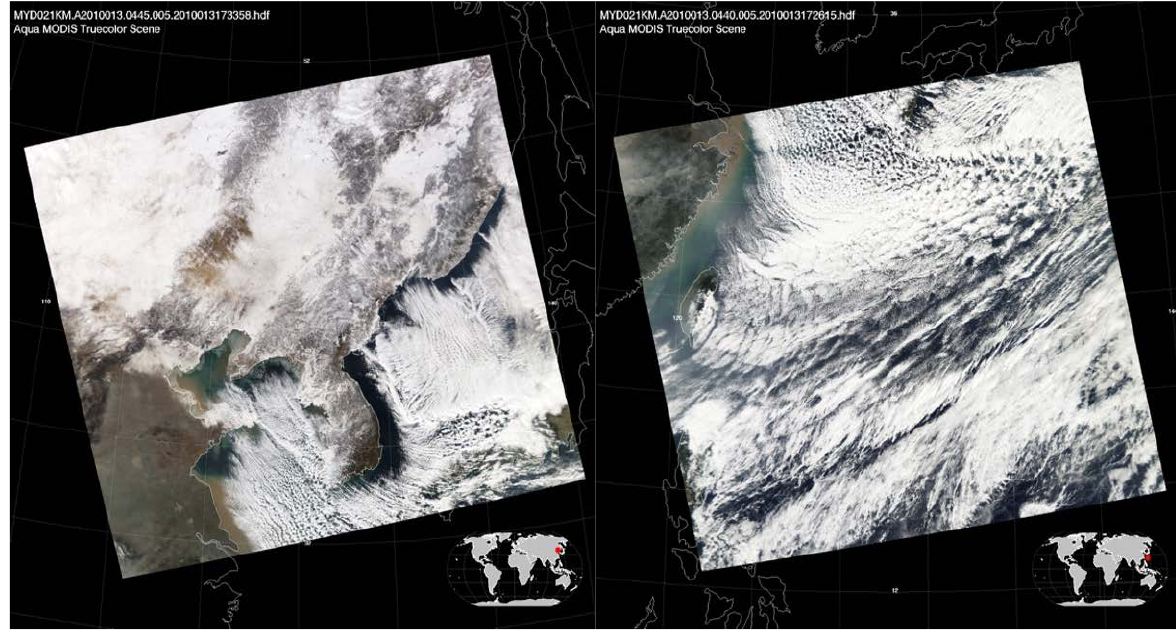
Figure 1. Example of marine stratocumulus during a cold surge event over East Asia from the true color image of MOderate Resolution Imaging Spectroradiometer (MODIS) on 13 January 2010. Left: at 04:45 UTC, overpassing northern China, the Korean Peninsula, and the Yellow Sea. Right: 04:40 UTC, overpassing southern China, Taiwan, and the northwestern Pacific. (https://ladsweb.modaps.eosdis.nasa.gov/search/imageViewer/42/MYD021KM--61/2010-01-13/DB/World/ 3077701375, accessed on 27 October